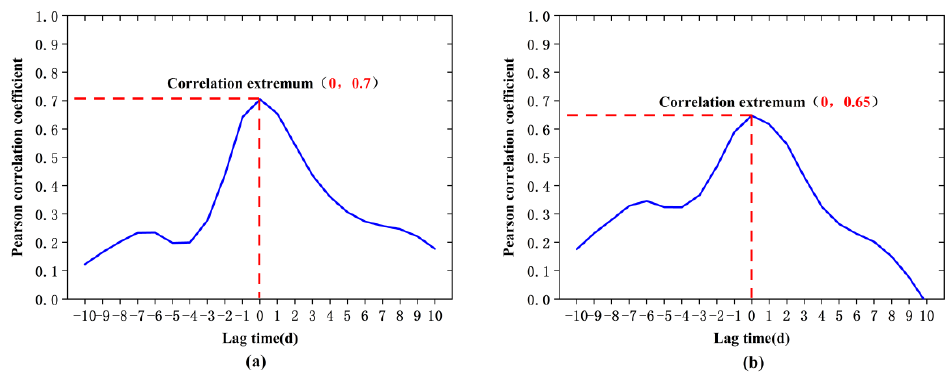
Figure 19. ( a ) Measured soil moisture; ( b ) inverse soil moisture and deformation rate time lag intercorrelation series.